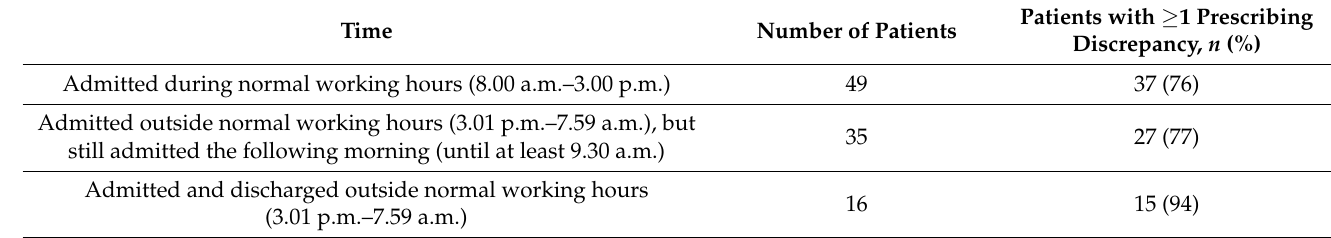
Table 4. Time intervals for admission and/or discharge in relation to the clinical pharmacists’ normal working